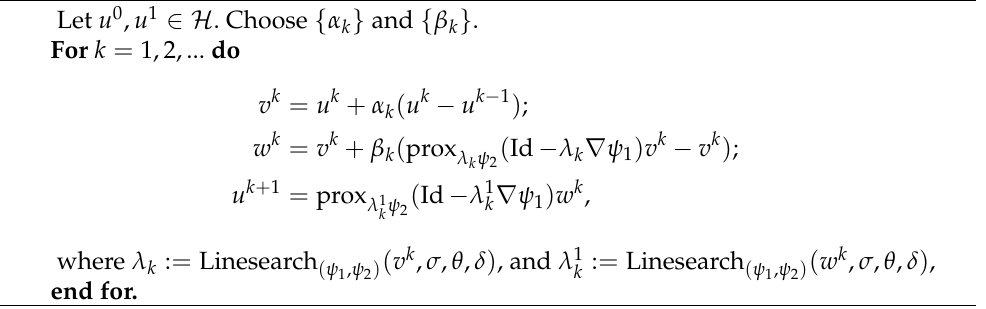
Algorithm 7 An inertial Picard–Mann forward–backward splitting method with line search